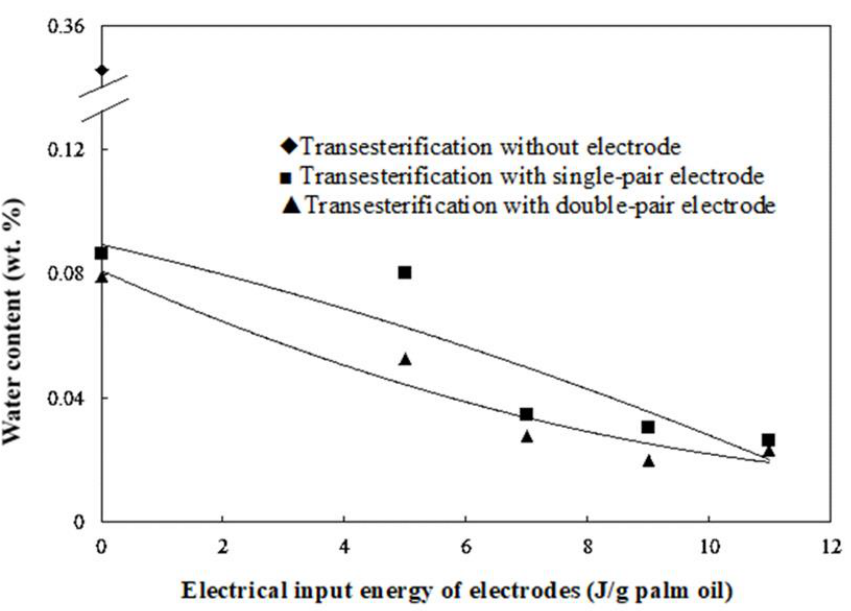
Figure 4. Effects of electrical energy input to electrodes for dissociating water on water content of biodiesel product.